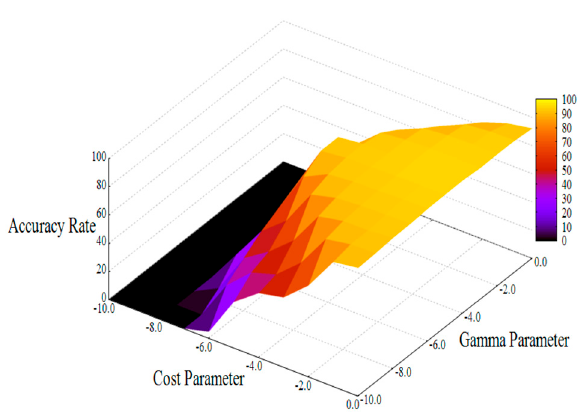
Figure 7. Diagnosis accuracy result of F1F2 in the case of SVM.